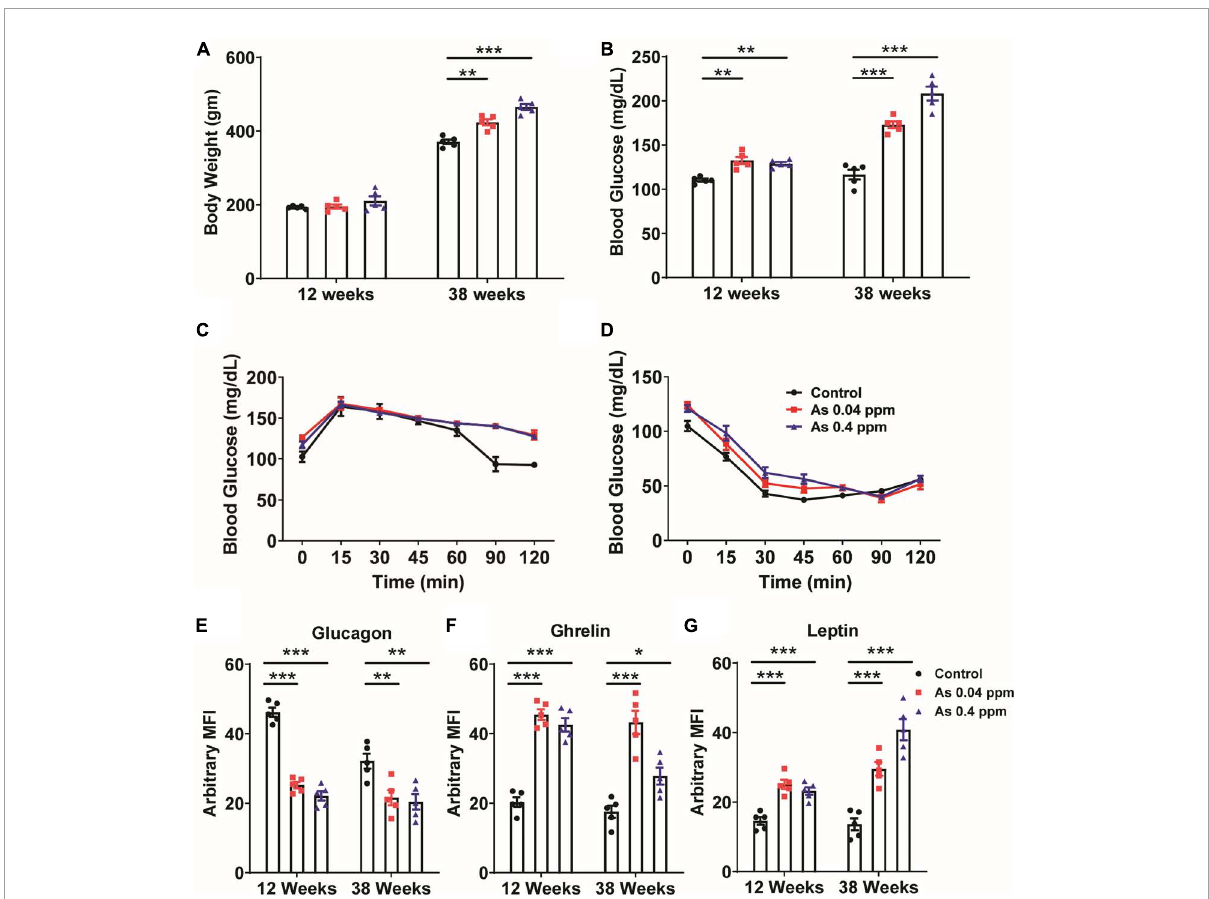
FIGURE2 Prenatal As exposure promoted weight gain, dysregulated glucose metabolism, and induced the expression of metabolic markers. Body weight (A) and blood glucose level (B) at 12 and 38 weeks of age. OGTT (C) and IPITT (D) at a 24-week time point. The levels of glucagon (E) , ghrelin (F) , and leptin (G) were determined in blood at 12 and 38 weeks of age. The data represent the mean ± SEM, n = 5 (number of experimental sets). * p < 0.05, ** p < 0.001, and *** p <